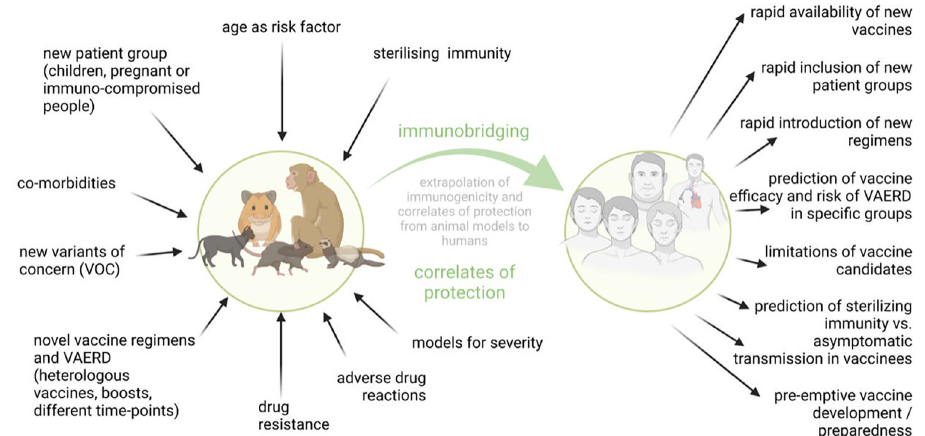
Fig 2. Animal models and immunobridging. Comparative and standardized studies in animal models such as those performed by WHO-COM scientists can help to extrapolate vaccine immunogenicity data across preclinical and clinical studies. Figure created with Biorender (Biorender.com). VAERD, vaccine-associated enhanced respiratory disease; VOC, variant of concern; WHO-COM, WHO COVID-19 Modeling group.